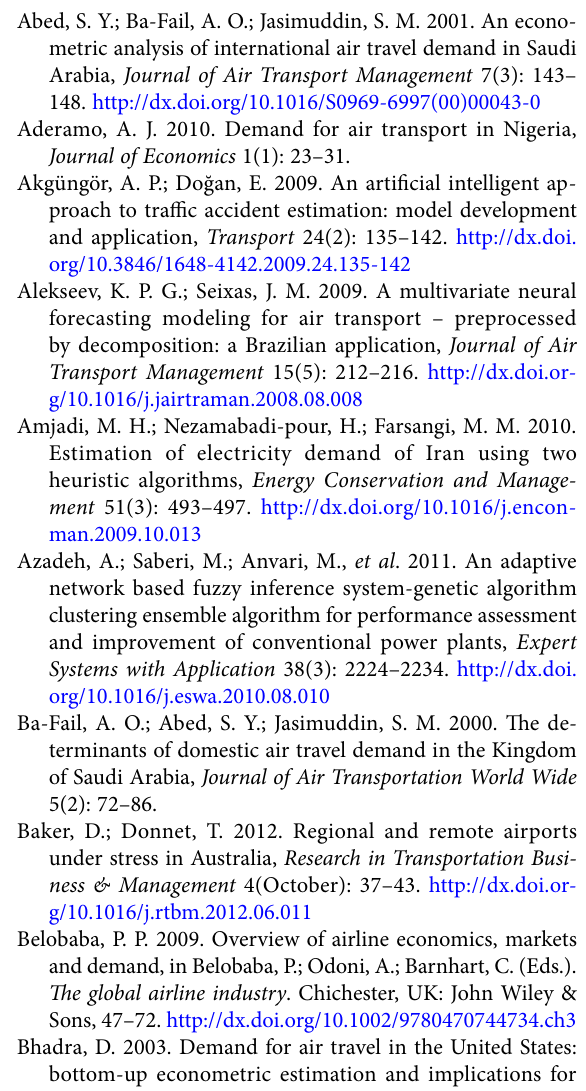
Fig. 3. A comparison of Australia’s actual and forecast domestic low cost carriers RPKs (GARPKSDE